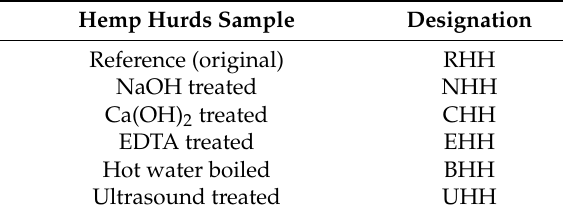
Table 2. Nomenclature of the modified hemp hurd